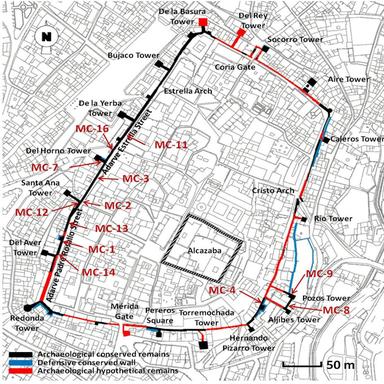
Schematic plant of the Cáceres old quarter surrounded by its ancient rampart (adapted from).